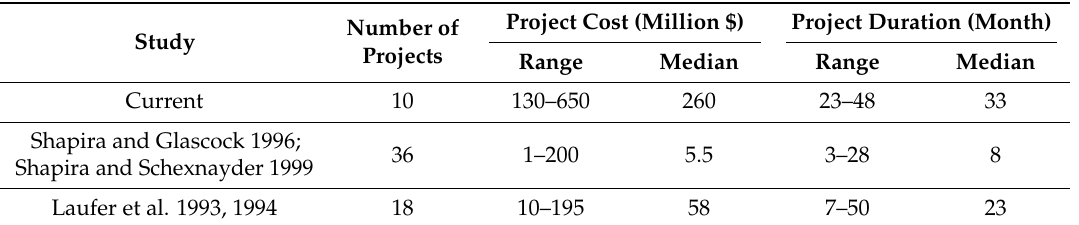
Table 3. Compared studies.